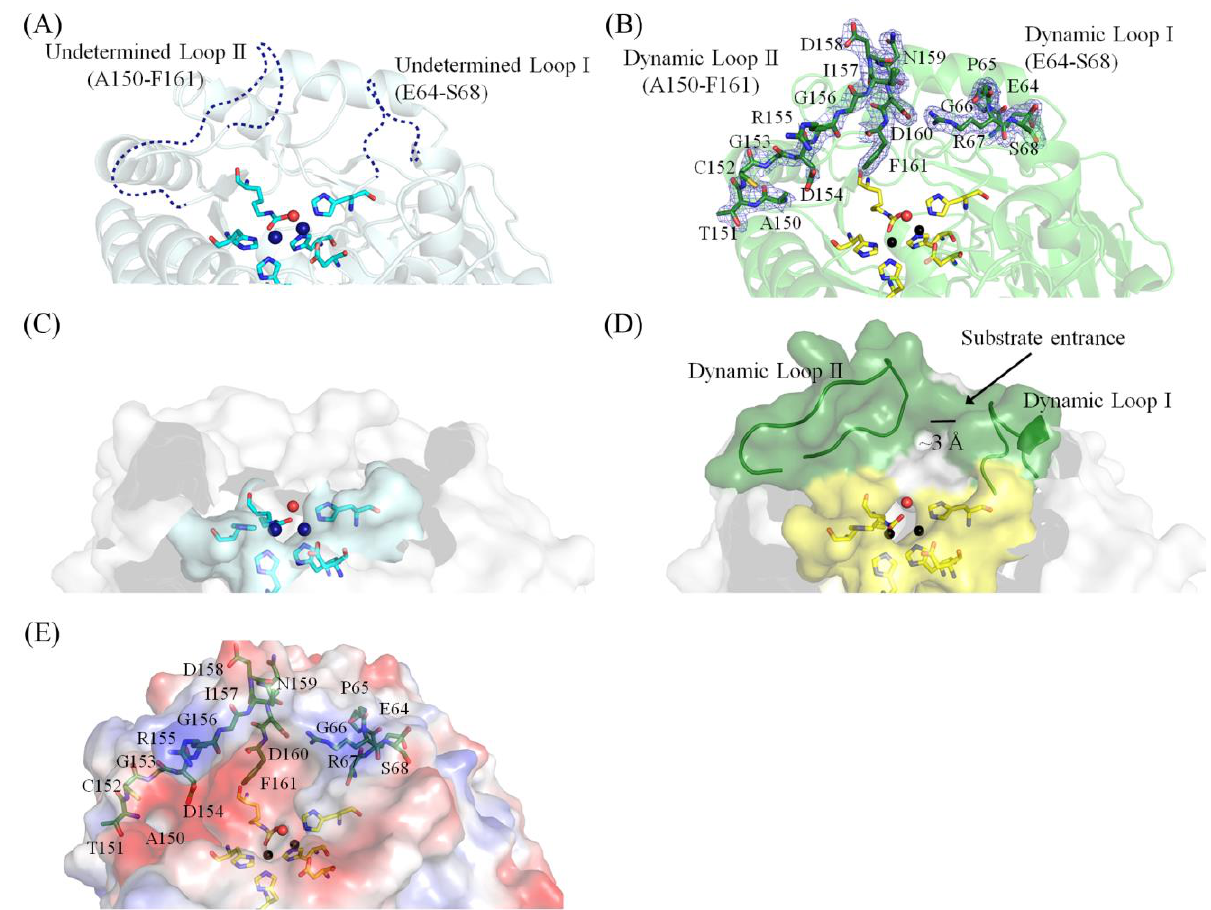
Figure 4. Dynamic loops and the tunnel bottleneck of EcALLase-BL21. ( A ) The active site of EcALLase-K12. The two active site loops crucial for substrate binding were not determined. These two dynamic loops in EcALLase-K12 are segments A58 – R67 (loop I) and G141 – N165 (loop II). When we used the structure of EcALLase-K12 for inhibitor docking and sketching the chemical mechanism, we found that it was difficult to draw a correct conclusion, probably due to the lack of structure for these two active site loops. ( B ) The active site of EcALLase-BL21. The electron density of the residues on the two dynamic loops in our structure of EcALLase-BL21 was well defined. ( C ) The tunnel bottleneck of EcALLase-K12. Because the structure of the two loops was not solved, the cross-section bottleneck size for substrate entrance could not be determined. ( D ) The tunnel bottleneck of EcALLase-BL21. The bottleneck size of the active site pocket of EcALLase-BL21 was approximately 3 Å. Given that the tunnel bottleneck (~3 Å) is narrower than the size of substrate allantoin (6 – 9 Å), this structure may be the closed form of EcALLase-BL21. ( E ) The electrostatic potential surface of the structure of EcALLase-BL21. Residues on the dynamic loops are indicated.